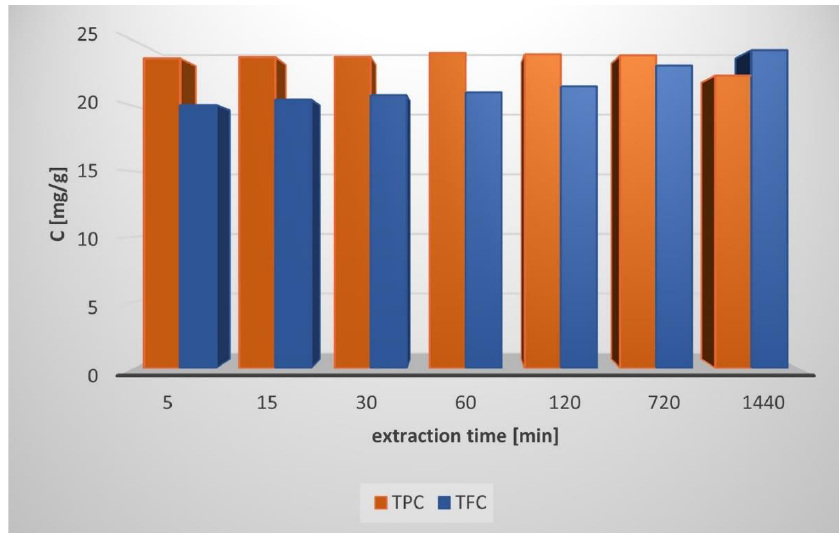
Figure 1. Total phenolic content (TPC) and total flavonoid content (TFC) vs. the time of extraction.